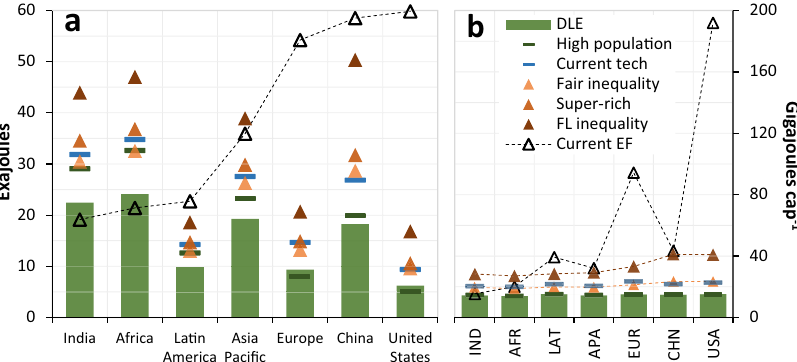
Fig. 4 | Final energy use by region alongside current fi nal energy footprints. Finalenergy isshown in absolute ( a ) and per-capita terms ( b ).Current fi nal energy footprints(EF)arefrom Oswald et al. (2020) 43 . Regions are orderedfrom lowest to highestabsoluteenergyfootprint,anddashedlinesareonlyincludedwhereatrend